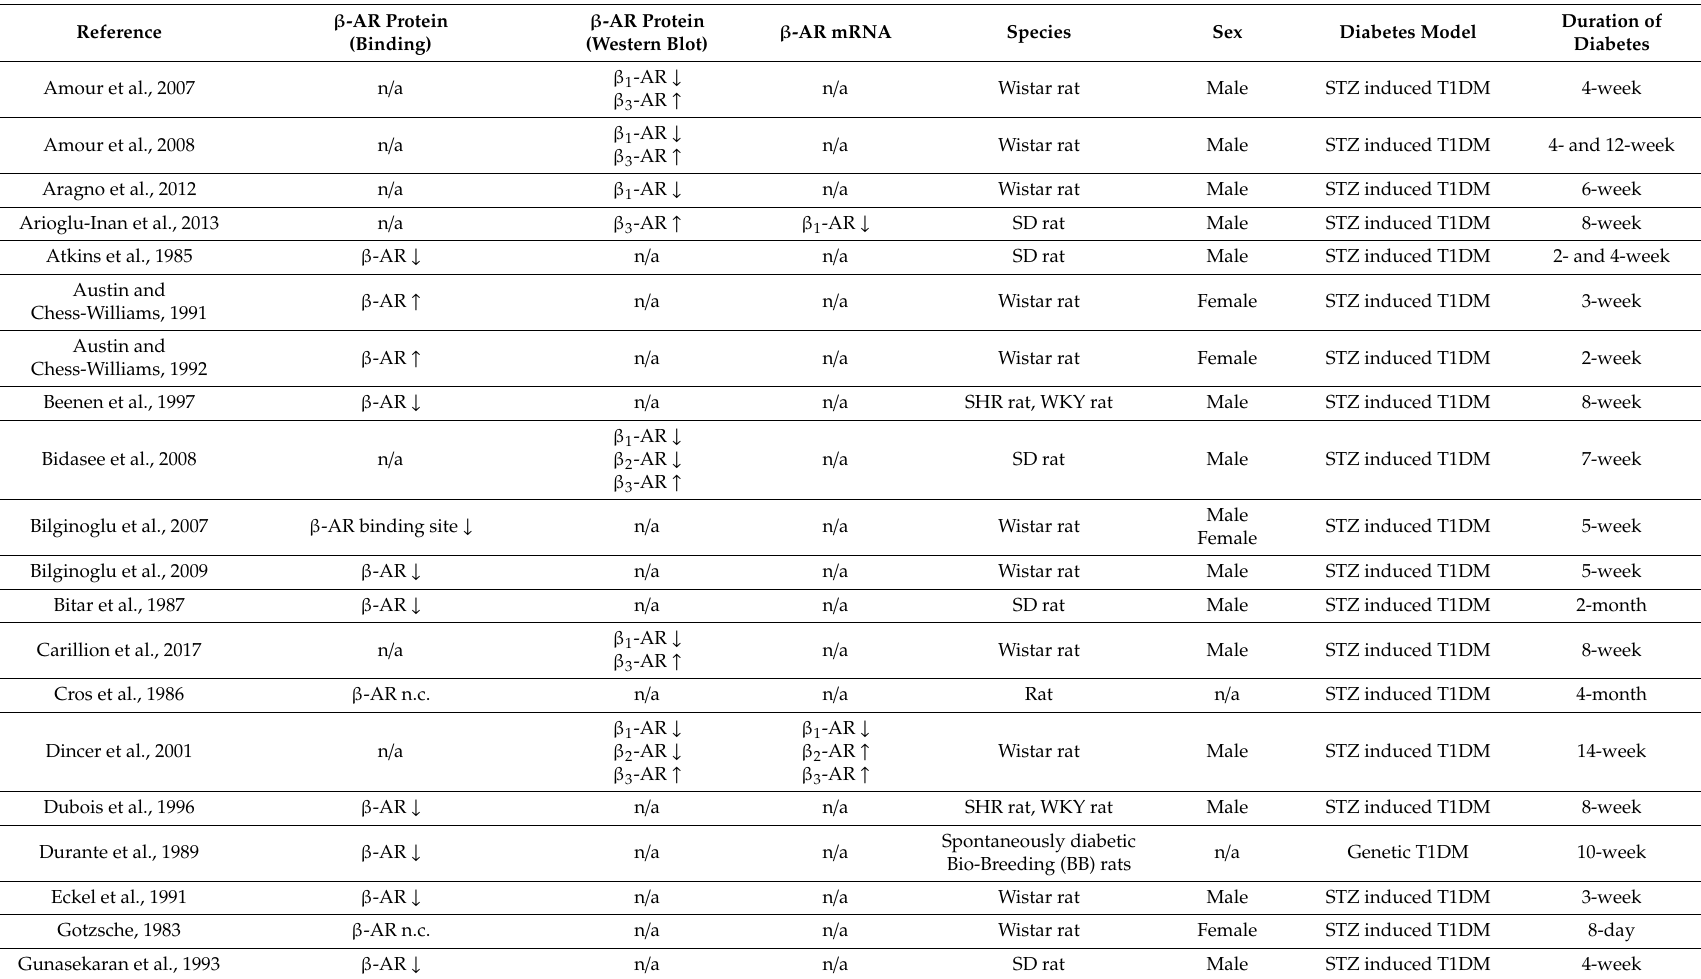
Table 1. Cardiac β -Adrenoceptors ( β -AR) protein and mRNA levels in type 1 (T1DM) and type 2 diabetes